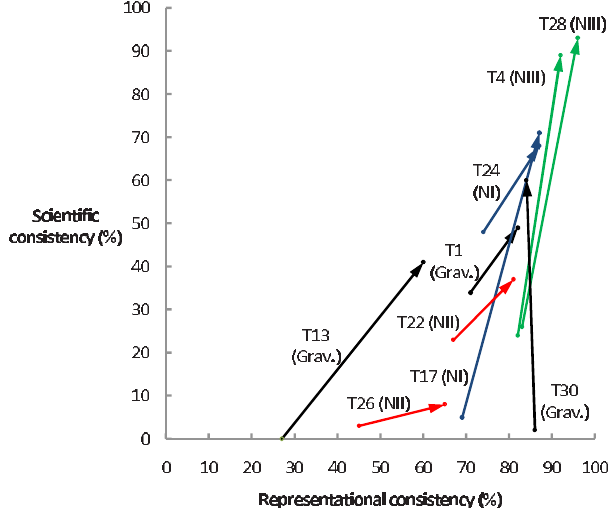
FIG. 4. (cid:1) Color (cid:2) Students’ progress in representational and scien- tific consistency between pre- and post-tests. The starting point of an arrow shows pretest results and the head shows post-test results.